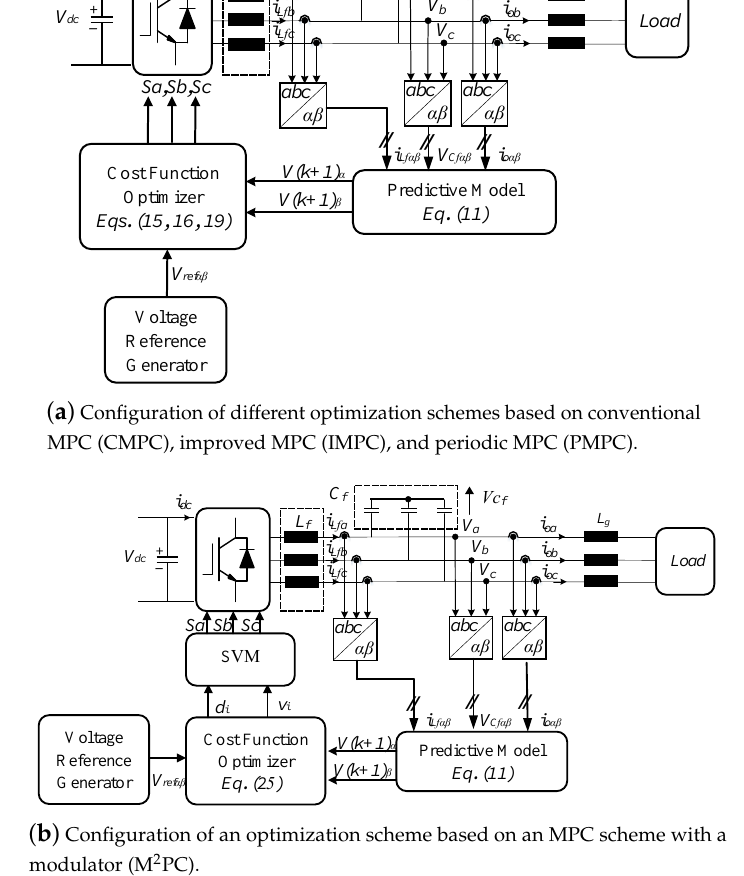
Figure 3. Various MPC schemes, where ( a ) depicts that no modulator was used; and ( b ) depicts that a modulator was